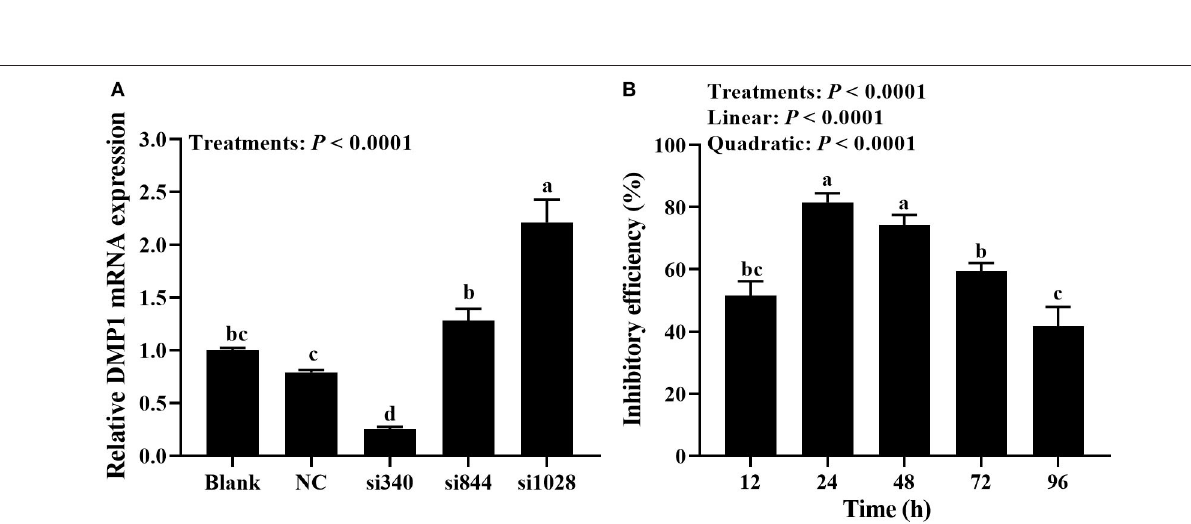
Frontiers in Veterinary Science |